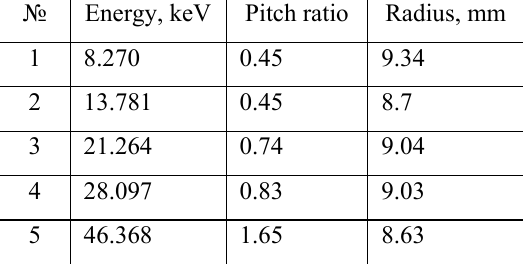
Table 2. Input parameters of electron